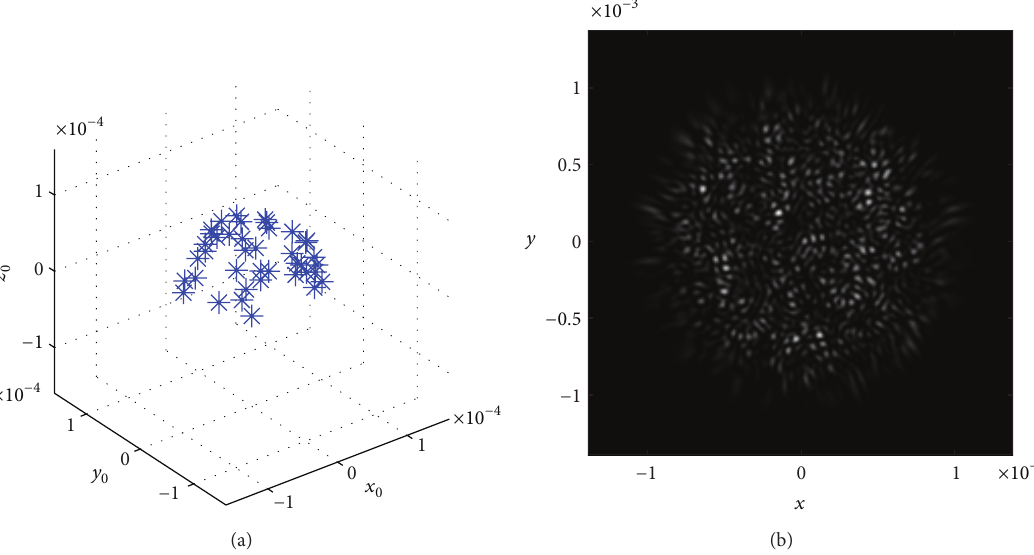
Figure 5: Half sphere composed of 40 randomly located Dirac emitters (a) and interferometric out-of-focus image created by this object (b). The radius of the half sphere is 80 micrometers. All axes are in meters.